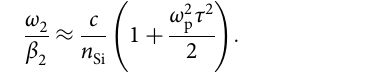
band, fl attening at low THz frequencies. Front-induced transi-